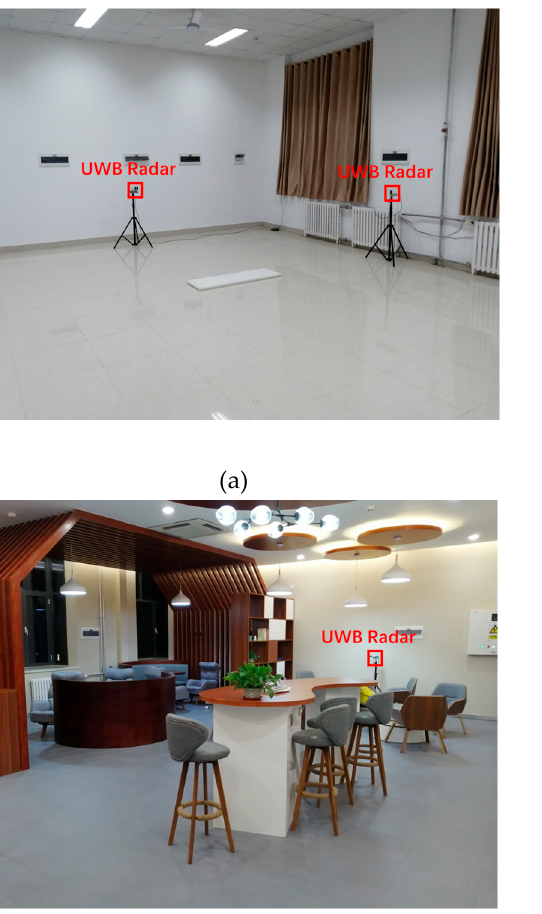
( b ) Figure 4. ( a ) The six activities considered in this work. ( b ) Training data examples with 20 frames per sample. Note that the samples in the picture covered the distance from 0.9 to 8.2 m. The size of the samples was 20 ◊ 800. Table 2. The gender, weight, and height of the test subjects. Test Subjects